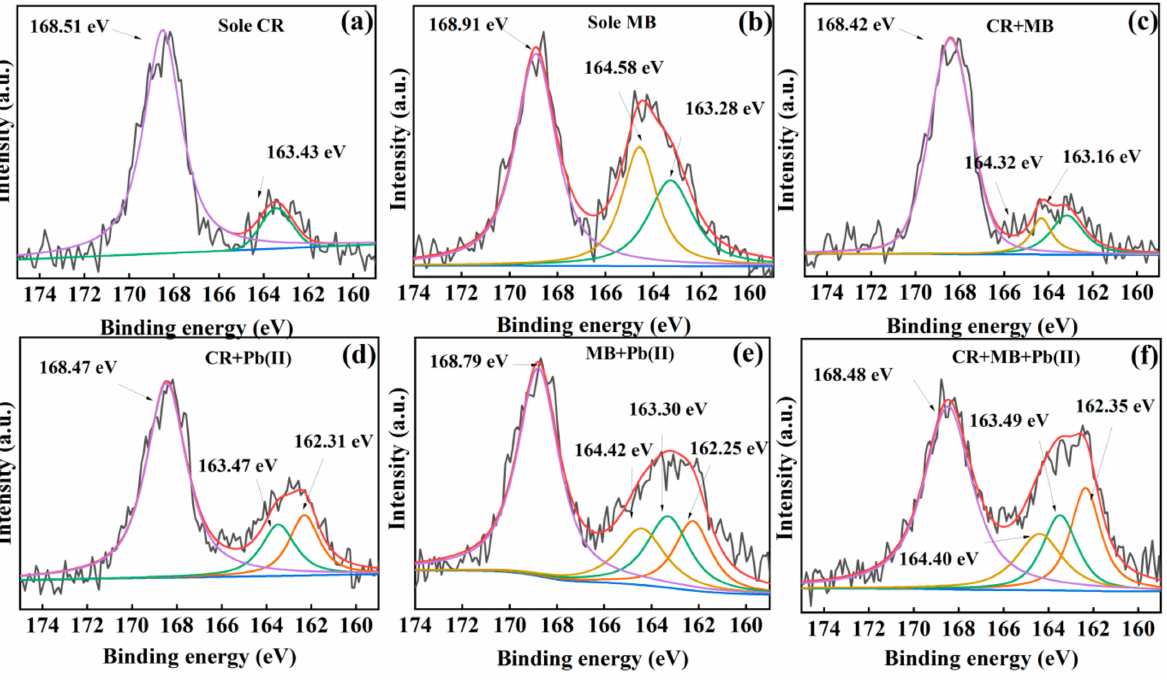
Figure 9. High-resolution S 2p XPS spectra of the HC–MgAlLDH after treating various systems: CR ( a ), MB ( b ), CR+MB ( c ), CR+Pb(II) ( d ), MB+Pb(II) ( e ) and CR+MB+Pb(II) ( f